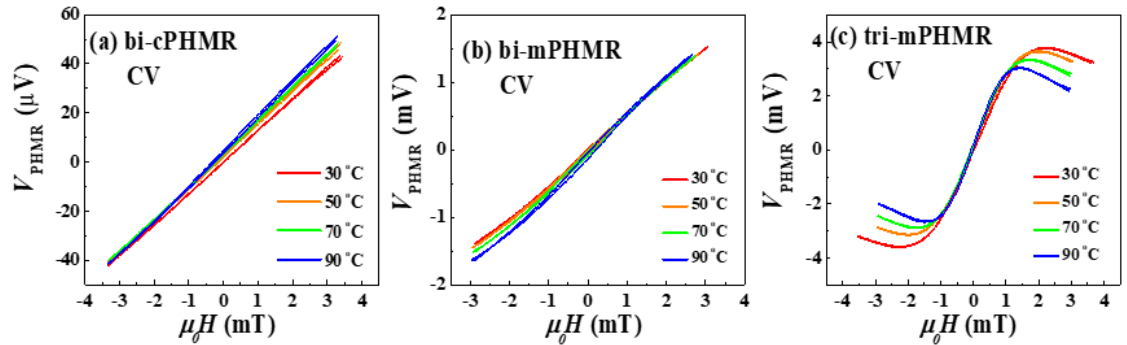
Figure A1. ( a – c ) Variation of amplified PHMR voltages with temperature for different sensors in CV mode.